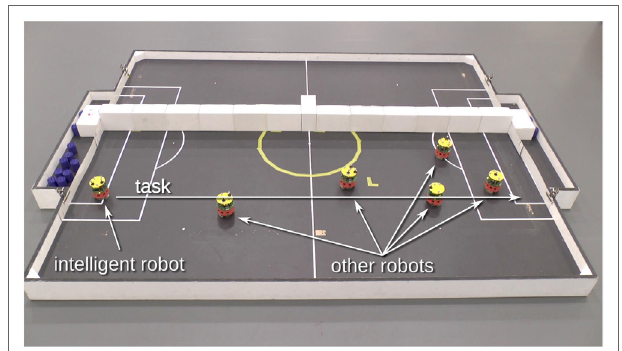
FigUre 8 | Experimental setup of the corridor with one smart and five h-robots. The smart robot is required to move from the left end of the corridor to the right, as indicated by the task arrow, avoiding the other h-robots which are also moving in the